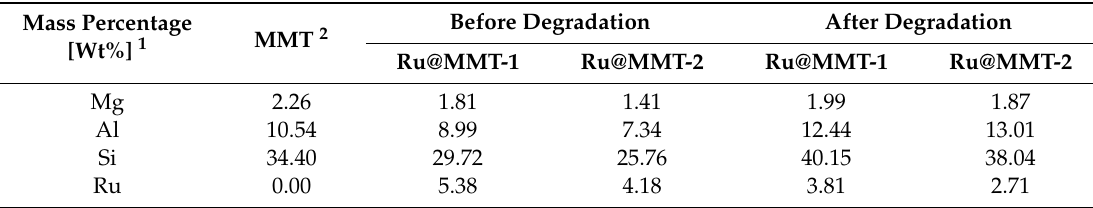
Table2. Thecomparisonofmainelementcontentispresentintwoproductsbeforeandafterdegradation.